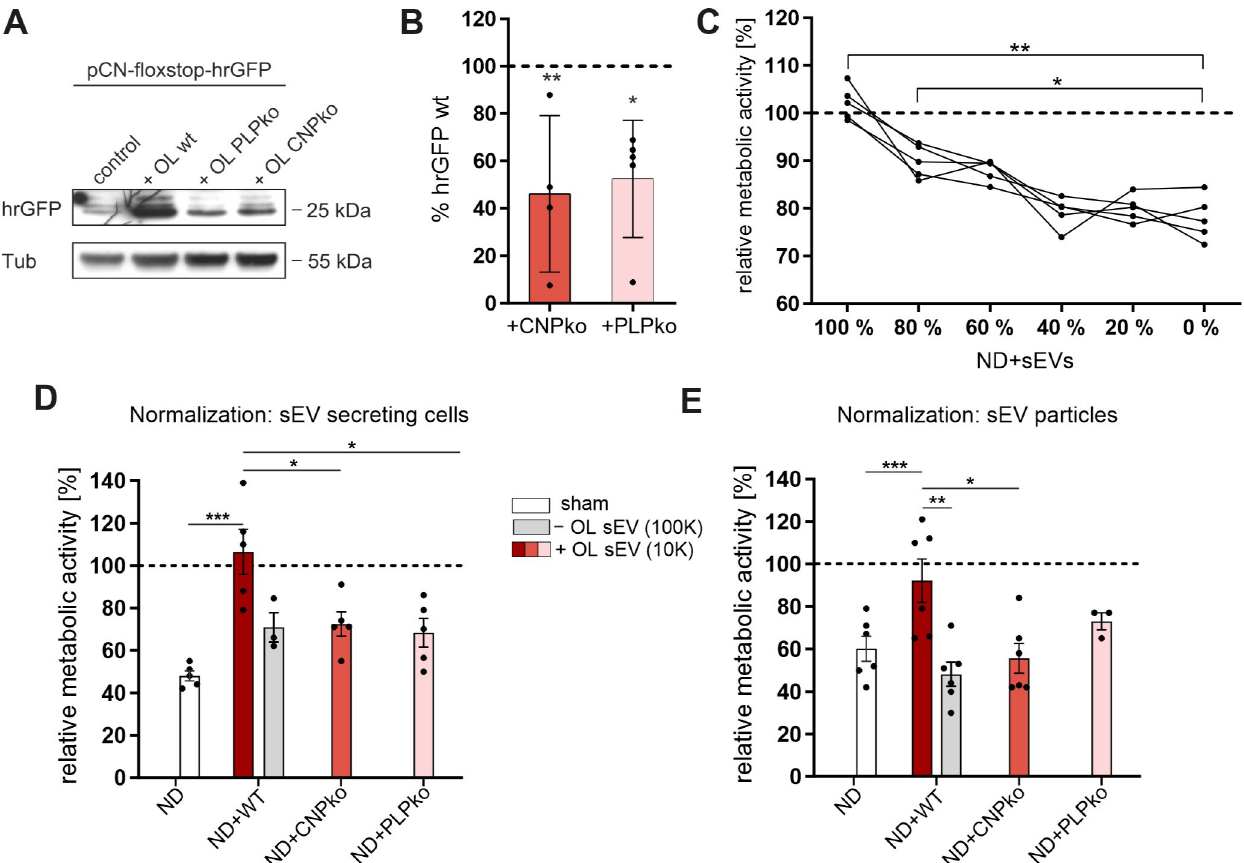
Fig 5. PLP- and CNP-null exosomes deliver cargo but lack functional activity. (A) Western blot showing hrGFP reporter gene activation in primary cortical neurons upon exposure to Cre-labeled oligodendroglial (OL) sEVs secreted from equal numbers of wild-type (WT), CNP-null (CNP knockout [CNPko]), or PLP-null (PLP knockout [PLPko]) oligodendrocytes. Control shows background in neurons not receiving Cre sEVs. Alpha-tubulin (Tub), loading control. (B) Quantitative representation of hrGFP Western blot signals normalized to alpha-tubulin and expressed relative to wild-type signal (dashed line). SEM, n = 4–5, ANOVA followed by Dunn’s multiple comparison test, � p < 0.05, �� p < 0.001. (C) Dose–response curve of sEV-mediated protection of cortical neurons from nutrient deprivation (ND). Metabolic activity was measured in neurons receiving a series of dilutions of sEV-containing supernatants derived from wild-type oligodendrocytes (100% = undiluted 10K supernatants, 0% = sEV-deprived 100K supernatants). Dashed line, reference of unstarved neurons ( n = 5, SEM), 1-way ANOVA test with Dunn’s multiple comparison test, � p < 0.05, �� p < 0.001. (D and E) Metabolic activity of cortical neurons subjected to nutrient deprivation (ND, sham) treated with sEV-containing 10K supernatants (+OL sEV) derived from wild-type (WT), CNP-null (CNPko), or PLP-null (PLPko) oligodendrocytes. Grey bar compares treatment with sEV-depleted 100K supernatants ( − OL sEV) derived from wild-type (WT) oligodendrocytes. Dashed line, reference of unstarved neurons. sEV input was normalized according to (D) the number of sEV-secreting cells ( n = 3–5, SEM) or (E) the number of particles applied to neurons, as determined by NTA ( n = 3–6), 2-tailed Student t test, � p < 0.05, �� p < 0.001, ��� p < 0.0001. Underlying images of blots and data can be found in S1 Images and S1 Data, respectively. 10K, 10,000 g- centrifuged; 100K, 100,000 g- centrifuged; CNP, 2 0 ,3 0 -cyclic nucleotide 3 0 -phosphodiesterase; ND, nutrient deprivation; OL, oligodendroglial; pCN, primary cortical neuron; PLP, proteolipid protein; SEM, standard error of the mean; sEV, small extracellular vesicle; WT,